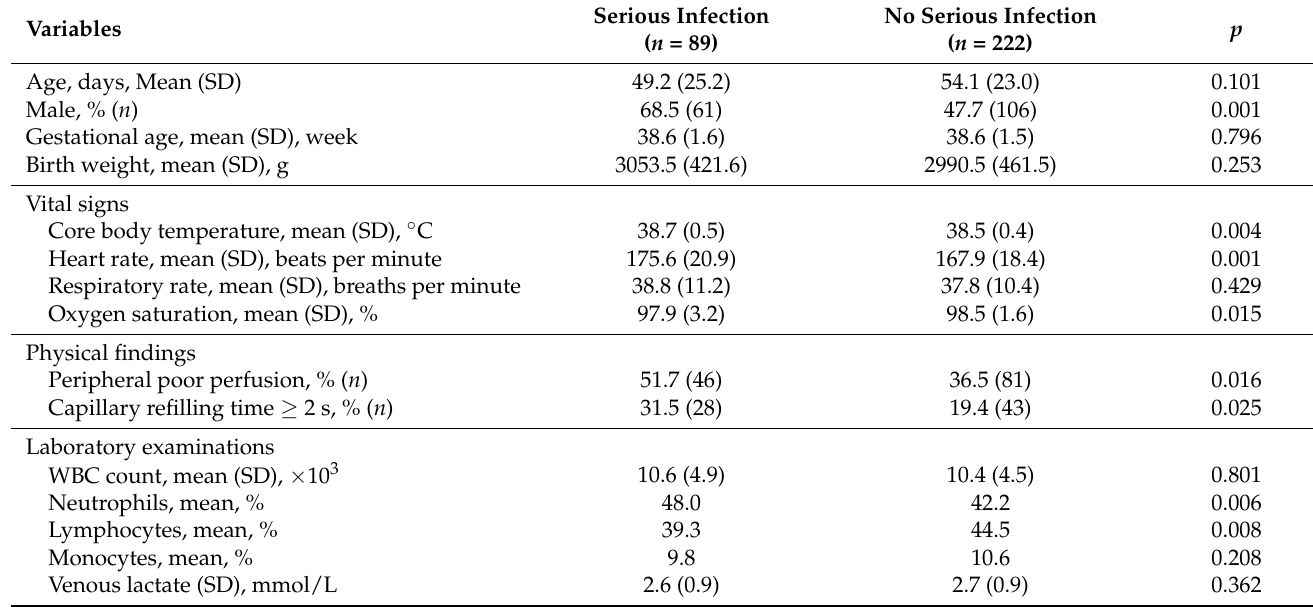
Table 3. Comparison of patients with and without a serious infection.